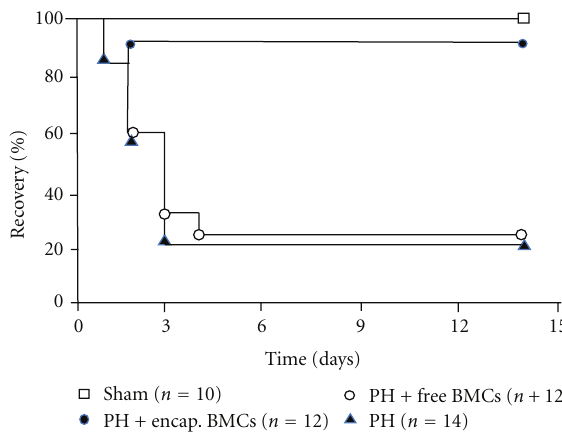
Figure 1: The percentage of recovery of rats.